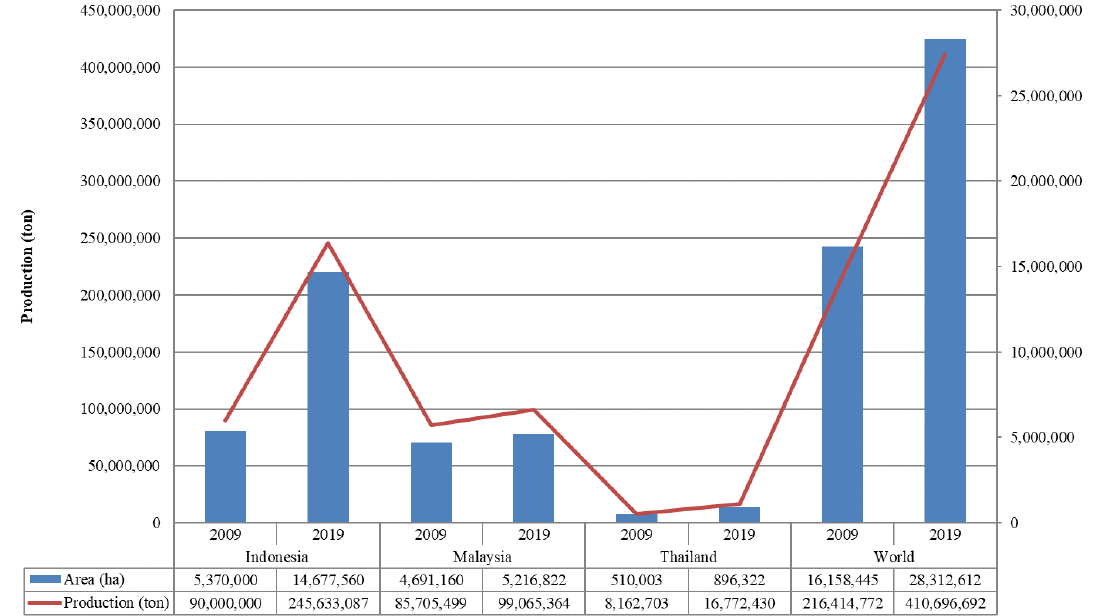
Figure 1. World area that was harvested and oil palm production within the predominant three countries in Southeast Asia during 2009–2019, Indonesia, Malaysia, and Thailand [12]. Both Indonesia and Malaysia produce 85% of the world’s palm oil [13], where oil palm estates occupy 22 of 34 provinces in Indonesia [10] and cover more than 60% of the agricultural land of both the west (the peninsular) and the east (the States of Sabah and Sarawak) in Malaysia [13]. The large extent of oil palm plantations in both countries has generated waste products in large quantities. For instance, the fibrous part can be gained after the removal of oil seeds from FFB for oil extraction which results in crude palm oil (CPO) and crude palm kernel oil (CPKO) that are derived from the mesocarp fiber (MF) and the palm kernel (the seed enclosed in a shell of the endocarp), respectively (Figure 2) [13].